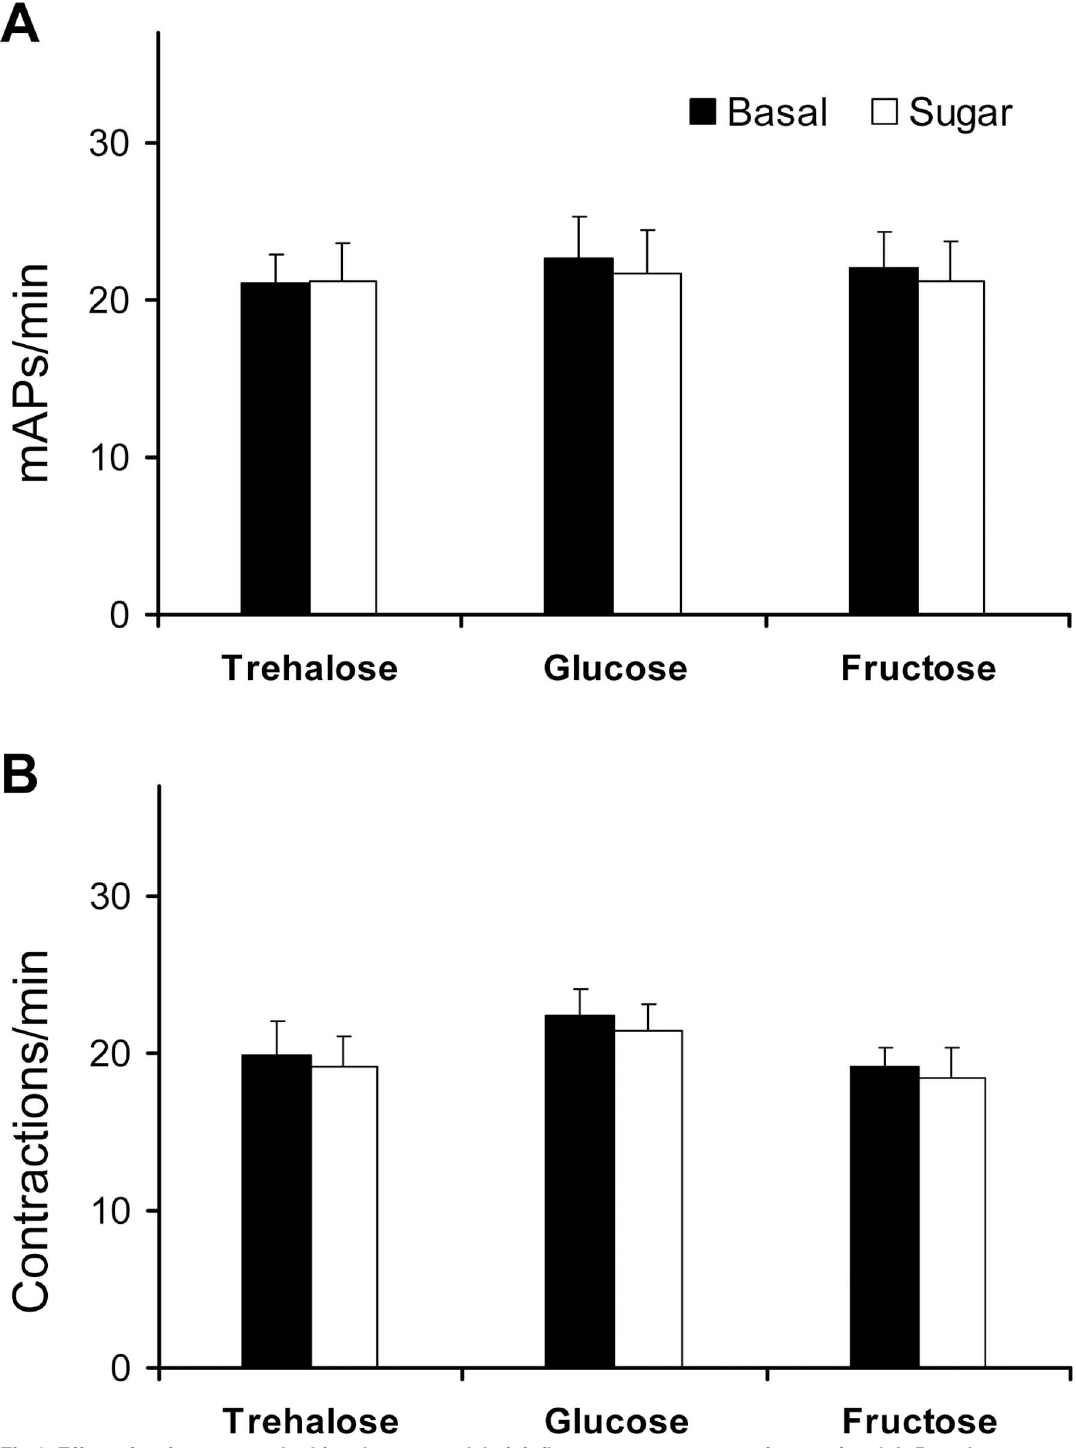
Fig 4. Effect of various sugarsbathing the crop and their influence on crop contraction rate in adult D . melanogaster . Frequency of mPAs electrophysiologicallyrecordedfrom P4 (a) and of contractions visuallyrecordedfrom P5 (b) of Drosophila Canton-Sstrain, determined over a 1-min interval,followingreplacement of hemolymph with 0.1 M trehalose,glucoseor fructose with respect to Drosophila saline(basal activity). Mean values ± SE (vertical bars) from 8 (trehalose and glucose)or 7